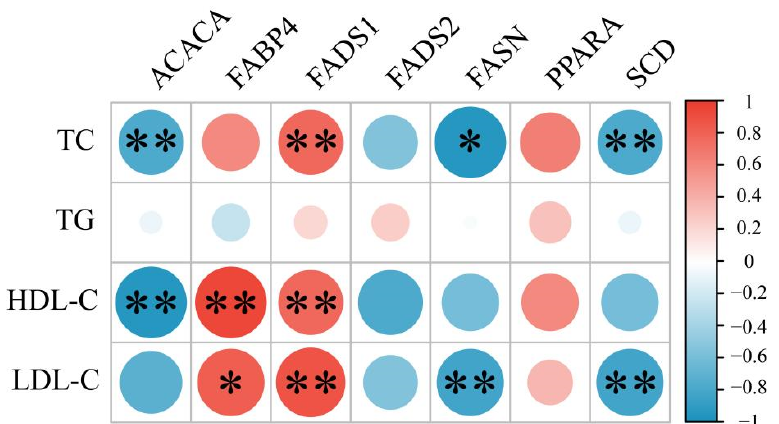
Figure 4. Heatmap of Spearman correlation coefficients between lipid parameters and lipid metabolism-related genes. “*” indicates a significant difference between the two groups ( p < 0.05), and “**” indicates an extremely significant difference between the two groups ( p < 0.01).